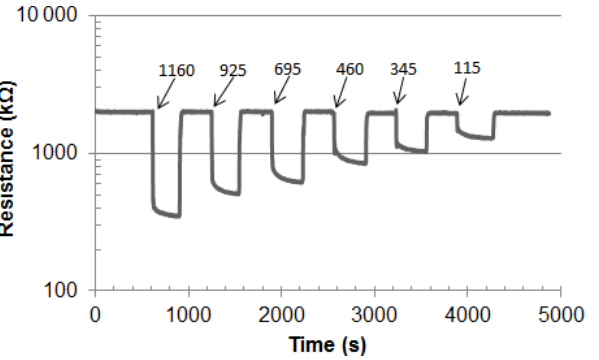
Figure 6. The response–recovery curves observed at different FA concentrations measured at 200 ◦ C operating